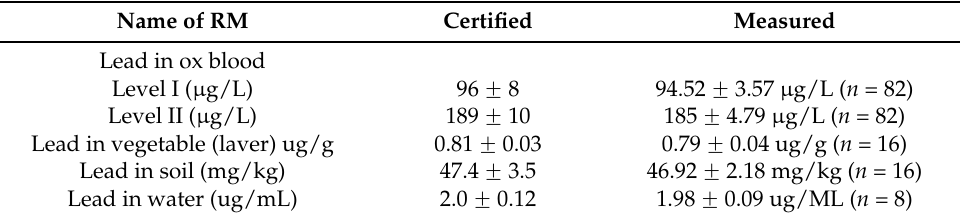
Table 1. Quality Assurance for Lead in Samples. The Reference Material (RM) results.